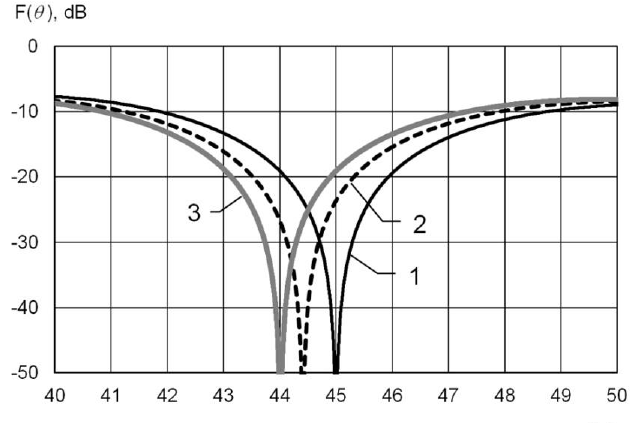
Fig. 5. Difference radiation patterns with a PAA diameter of 10 λ near the direction of the deflected beam